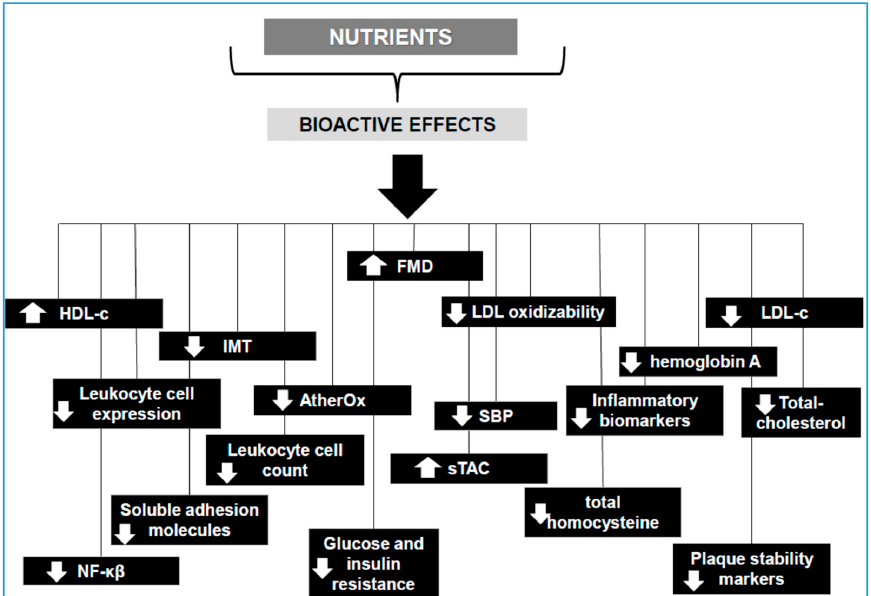
Figure 1. Summary of the main health effects of the nutrients described and their potential effects on the prevention of atherosclerosis. Abbreviations: AtherOx: oxidized low-density lipoprotein (LDL)- β 2 glycoprotein1 complex; FMD: flow-mediated dilatation; HDL-c: high-density lipoprotein cholesterol; IMT: intima-media thickness; LDL-c: low-density lipoprotein-cholesterol; NF- κβ : nuclear factor κβ ; SBP: systolic blood pressure; sTAC: serum total antioxidant capacity.